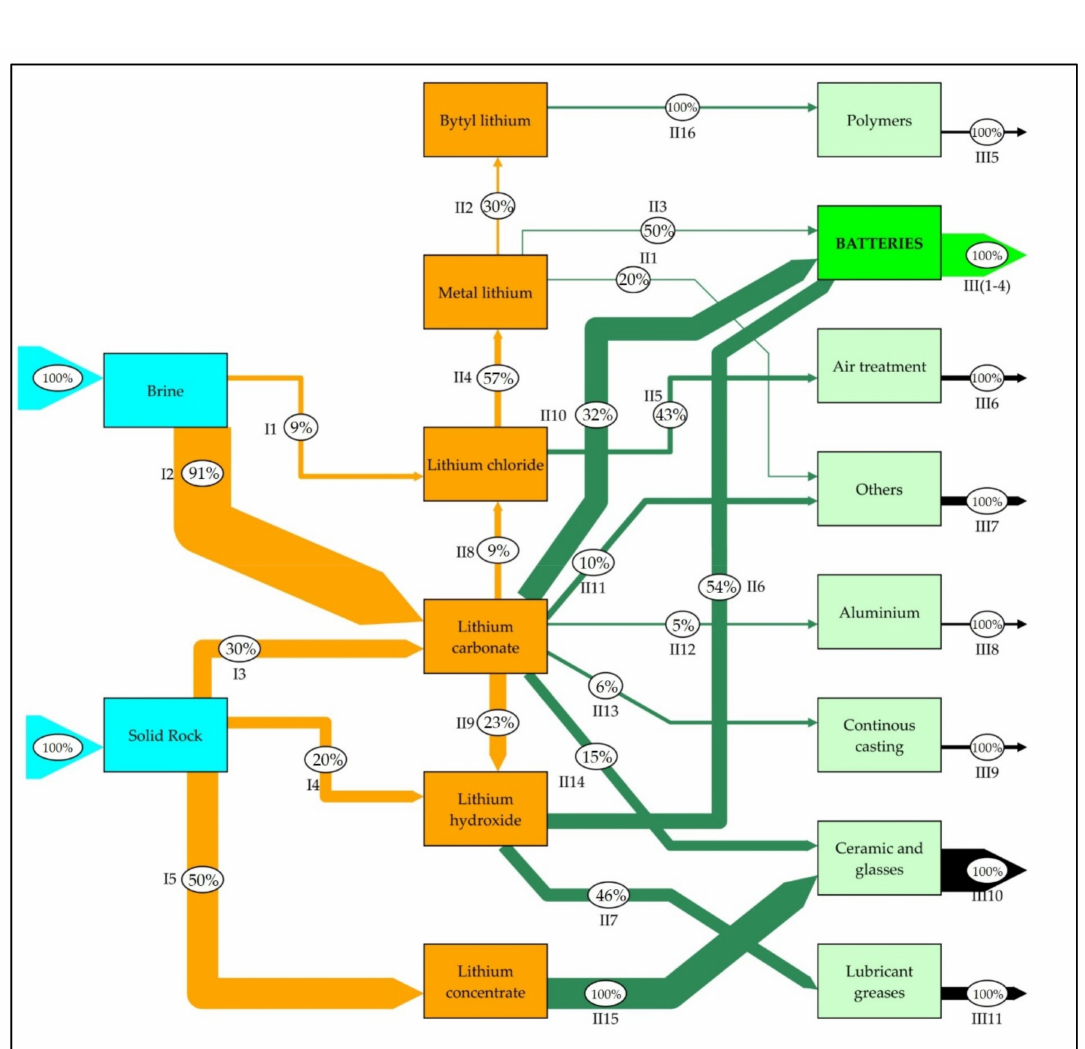
Figure 2. Material flow analysis of lithium: Resource mining is in blue, chemical production is in orange, and product manufacturing is in green. Arrows represent the paths between the supply chain stages. The ovals indicate the value of the distribution variable (%) for each path; data from Center of Energy Economics